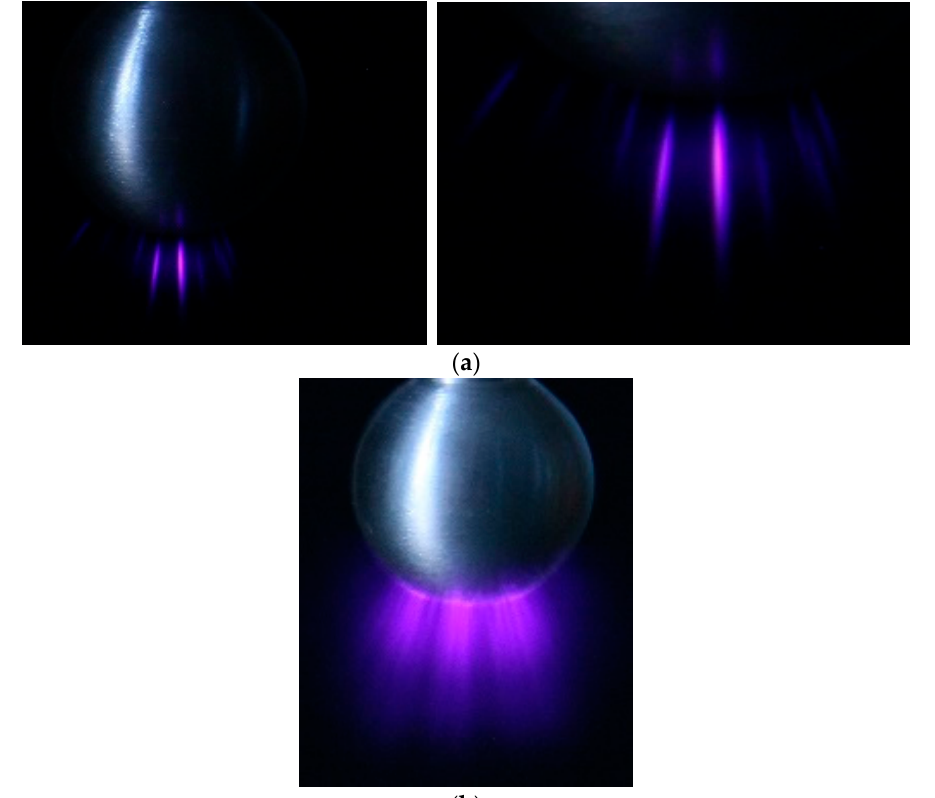
Figure 4. Negative polarity dc corona (sphere diameter of 20 mm, h = 15 cm). ( a ) Corona close to the extinction conditions ( − 54.5 kV) with few moving streamers; ( b ) Advanced negative corona at − 75 kV showing an amalgam of moving surface streamers.